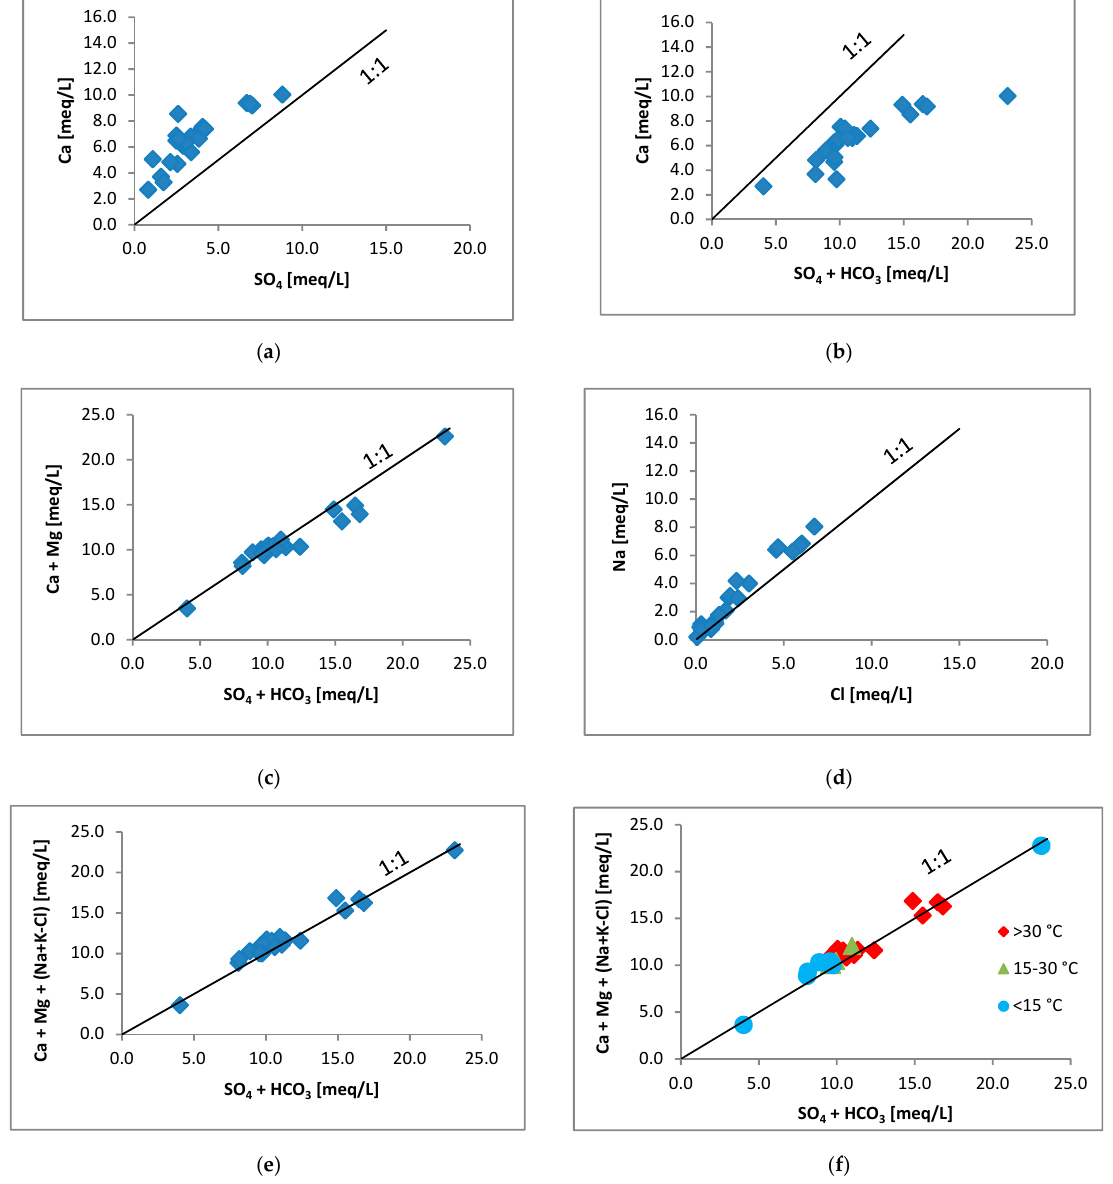
Figure 4. Graphs showing the relationship between the chemical components of the studied waters. Every component is in milliequivalent/litre (meq/L). The 1:1 line indicates the congruent dissolution(s) involved. ( a ) Ca versus SO 4 ; ( b ) Ca versus SO 4 + HCO 3 ; ( c ) Ca + Mg versus SO 4 + HCO 3 ; ( d ) Na versus Cl; ( e ) and ( f ) Ca + Mg + (Na + K–Cl) versus SO 4 + HCO 3 .